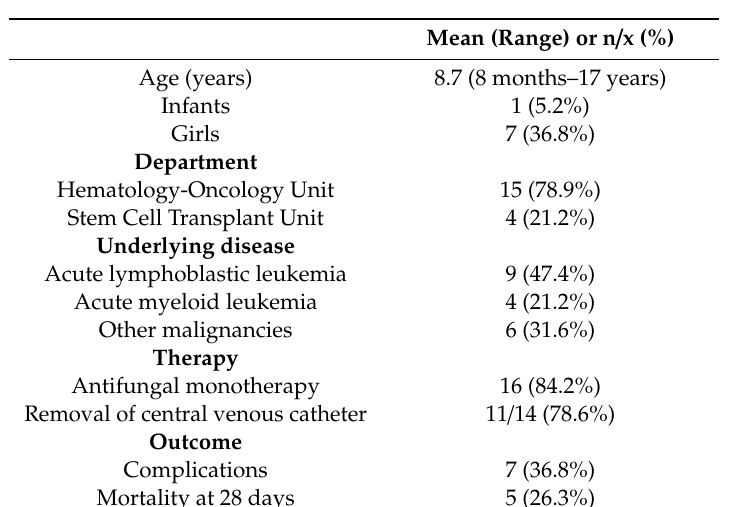
Table 1. Demographic data, therapy and outcome of patients with